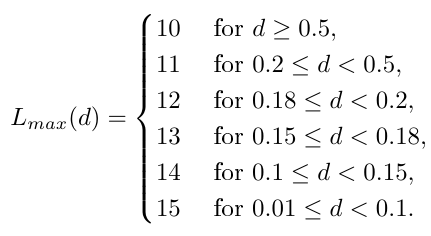
pends on both d and D . This truncation order tends to in(cid:28)nity as both d and D go to 0